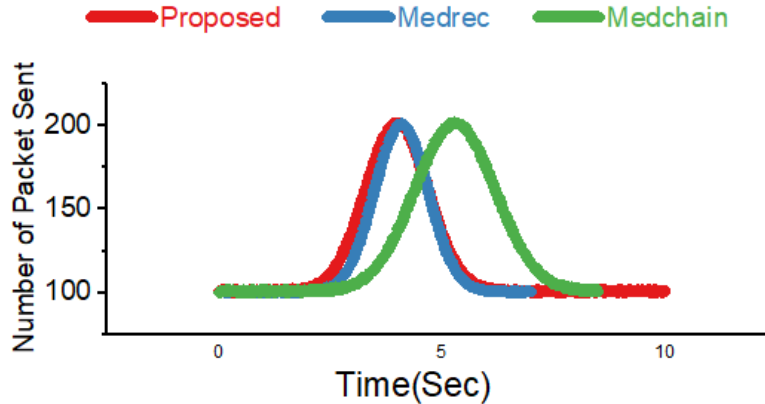
Figure 4. Comparative analysis of different blockchain-based domains.